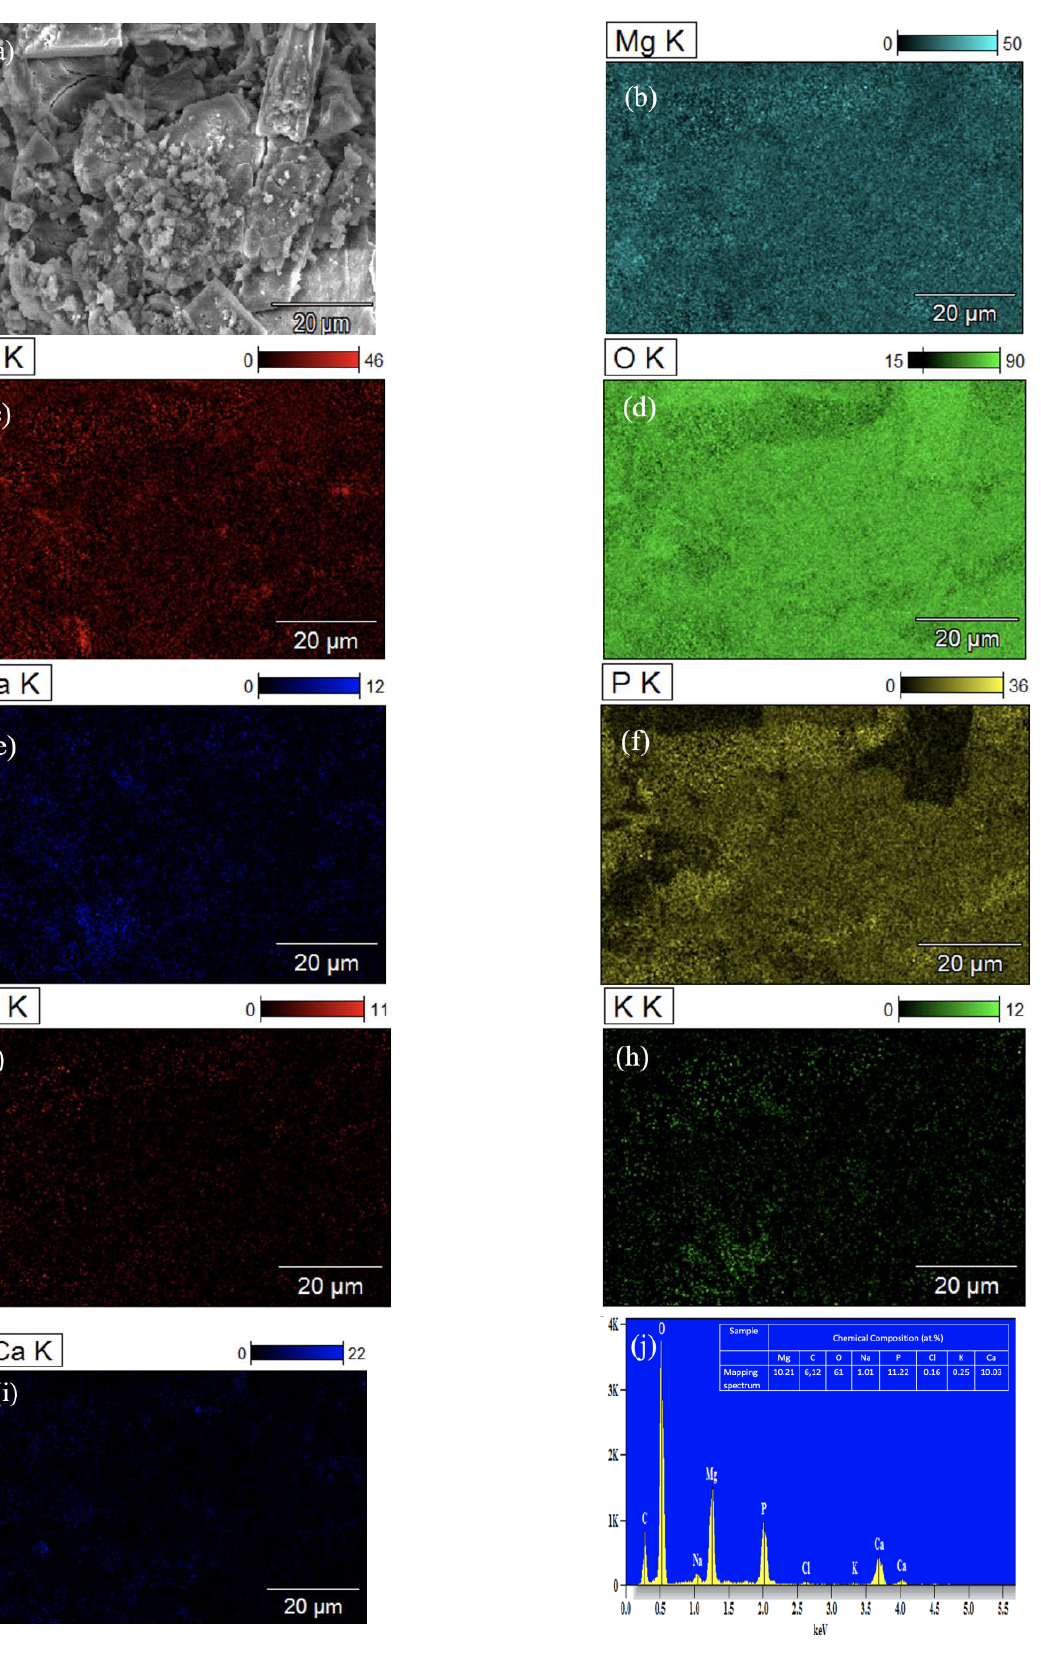
Figure 12. EDS analysis of ZX10-2ND: ( a ) image; ( b ) Mg; ( c ) C; ( d ) O; ( e ) Na; ( f ) P; ( g ) Cl; ( h ) K; ( i ) Ca; and ( j ) spectrum.